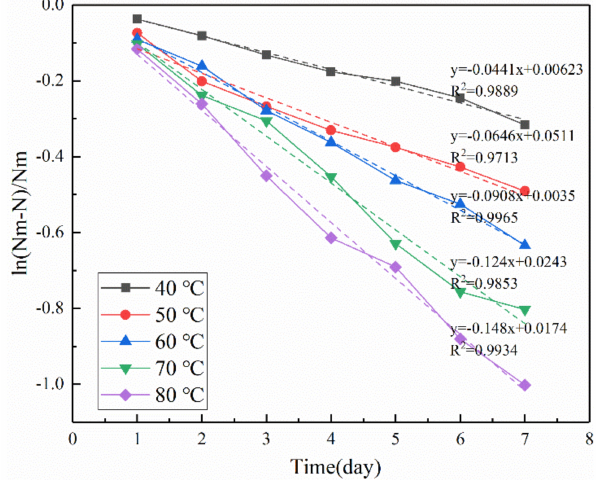
Figure 3. Variation Fitting curves of ln( Nm − N )/ Nm with storage time.